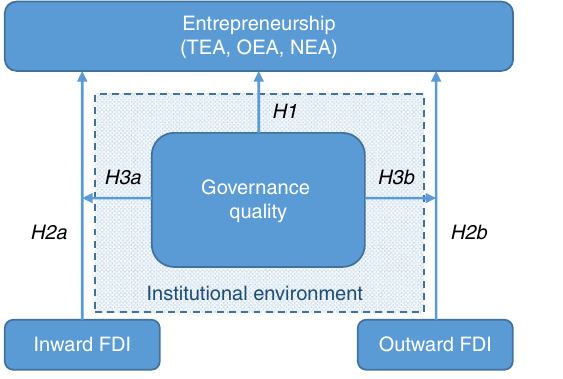
Figure 1. Illustration of